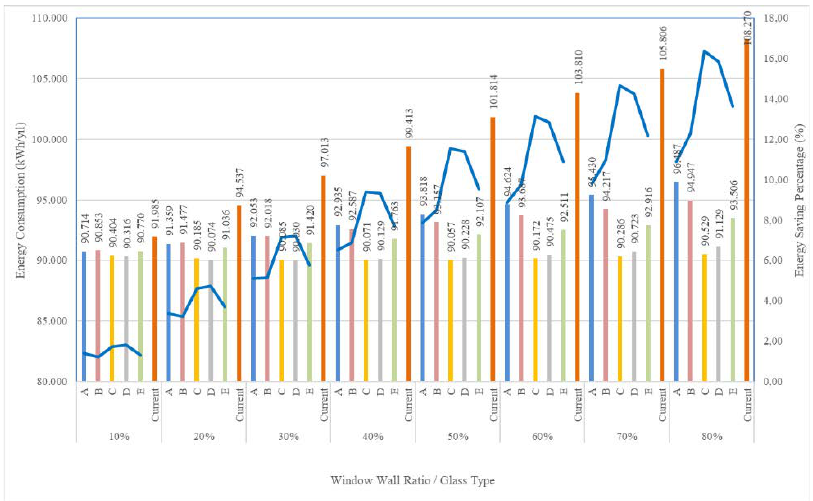
Figure 9 Energy saving rates, calculated energy consumptions and reference energy consumptions for Northeast